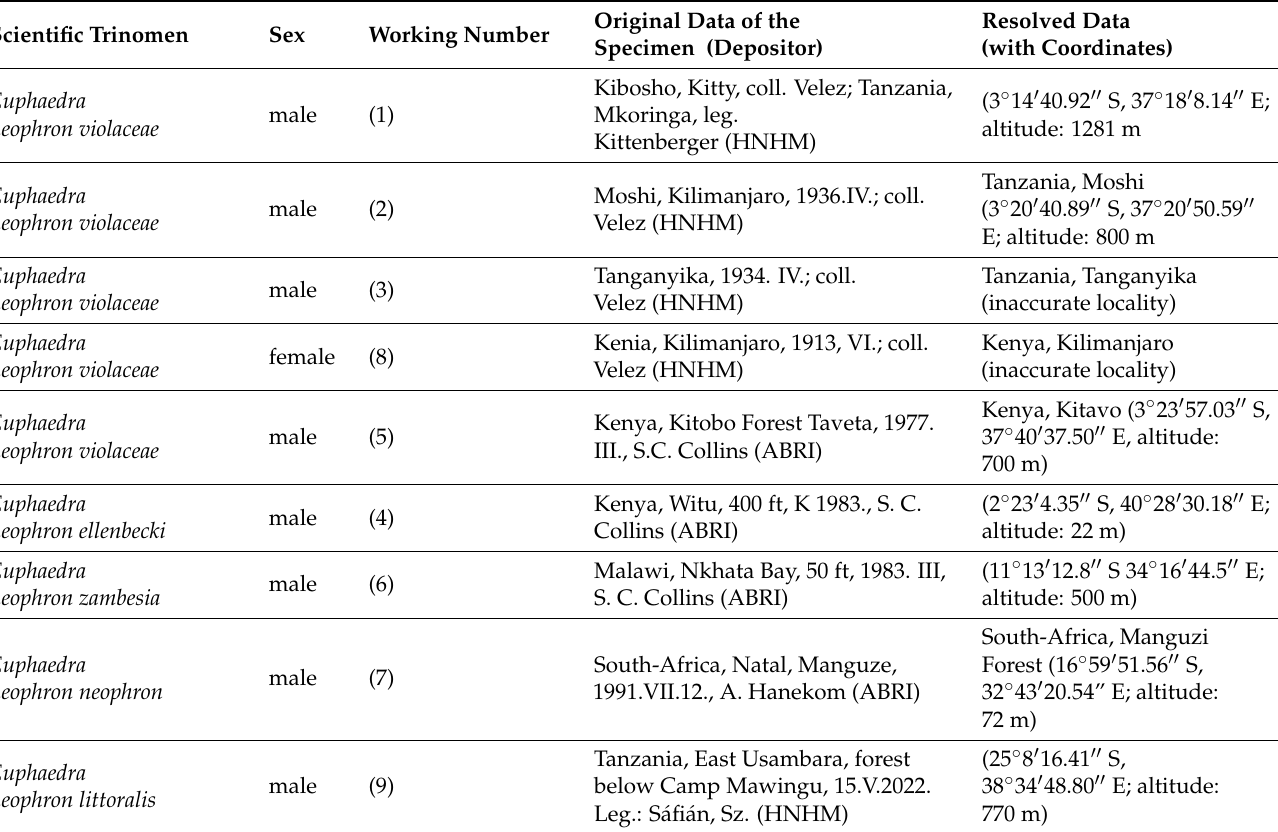
Table 2. List of specimens examined. Abbreviations: ABRI = African Butterfly Institute, HNHM = Hungarian Natural History